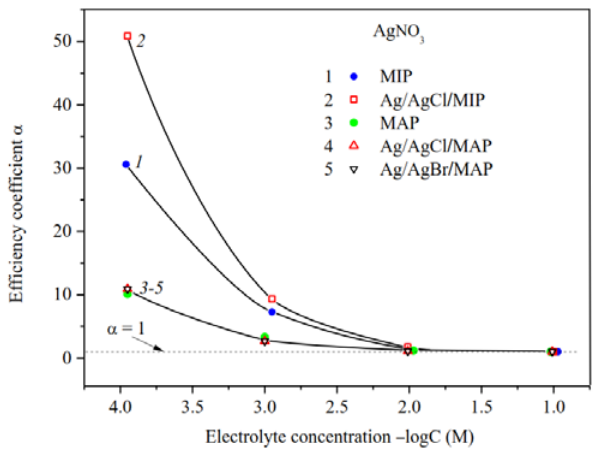
Figure 8. Efficiency coefficients of the base (Ermakova, 2022. Ref. [34]), Ag/AgCl/MIP and Ag/AgHal/MAP membranes vs. AgNO 3 solution concentration.